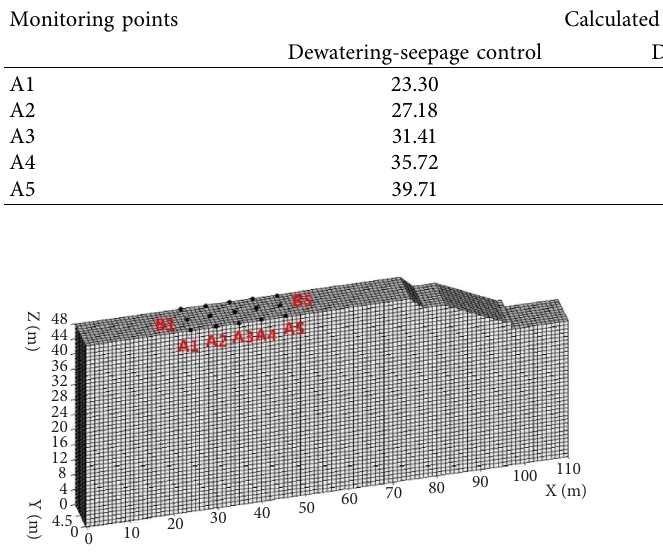
Figure 8: Te location graph for monitoring points.